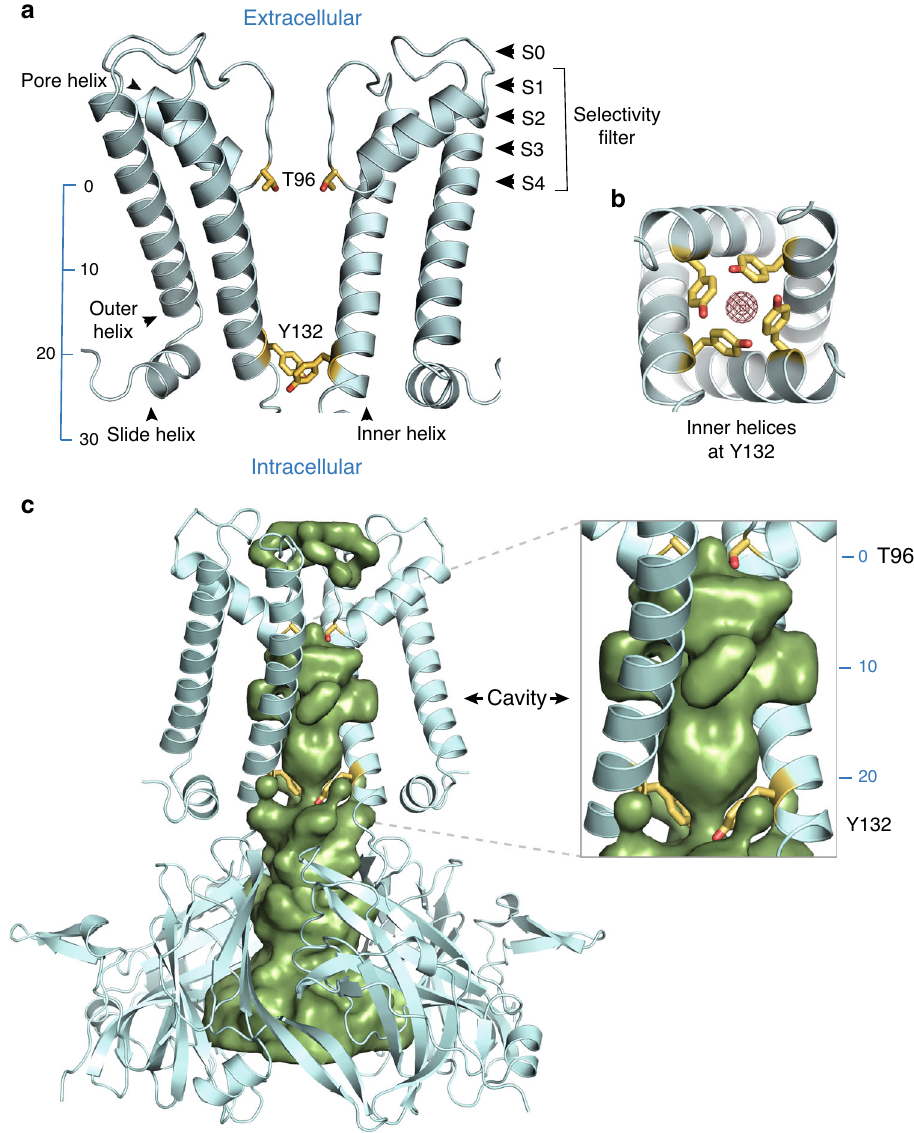
Fig. 1 Features of the KirBac3.1 pore. a Ribbon diagram of the wild-type KirBac3.1 pore in which two subunits are removed for clarity. A scale bar is provided indicating the distance (Å) from the center of mass of Thr96 and the potassium-binding sites S0 to S4 in the selectivity fi lter are indicated. b Transverse section showing that the conformation of the four inner helices maintains a narrow constriction at Tyr132. Density corresponding to K + ions is shown as brown mesh. c Accessible pore surface (green) along the molecular tetrad of wild-type KirBac3.1. Surface calculations were performed with HOLLOW. Two pore domain subunits have been removed for clarity. On the right is a close-up of the cavity through the membrane, showing how the cavity tapers to an hourglass at Tyr132. Tyr132 and Thr96 are represented as sticks